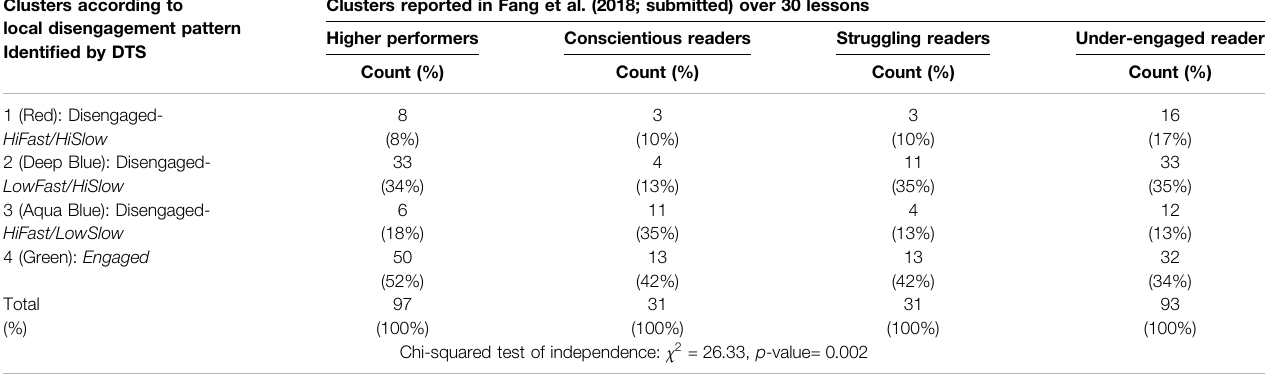
TABLE 4 | Comparisons of clusters of 252 participants. Clusters according to local disengagement pattern Identi fi ed by